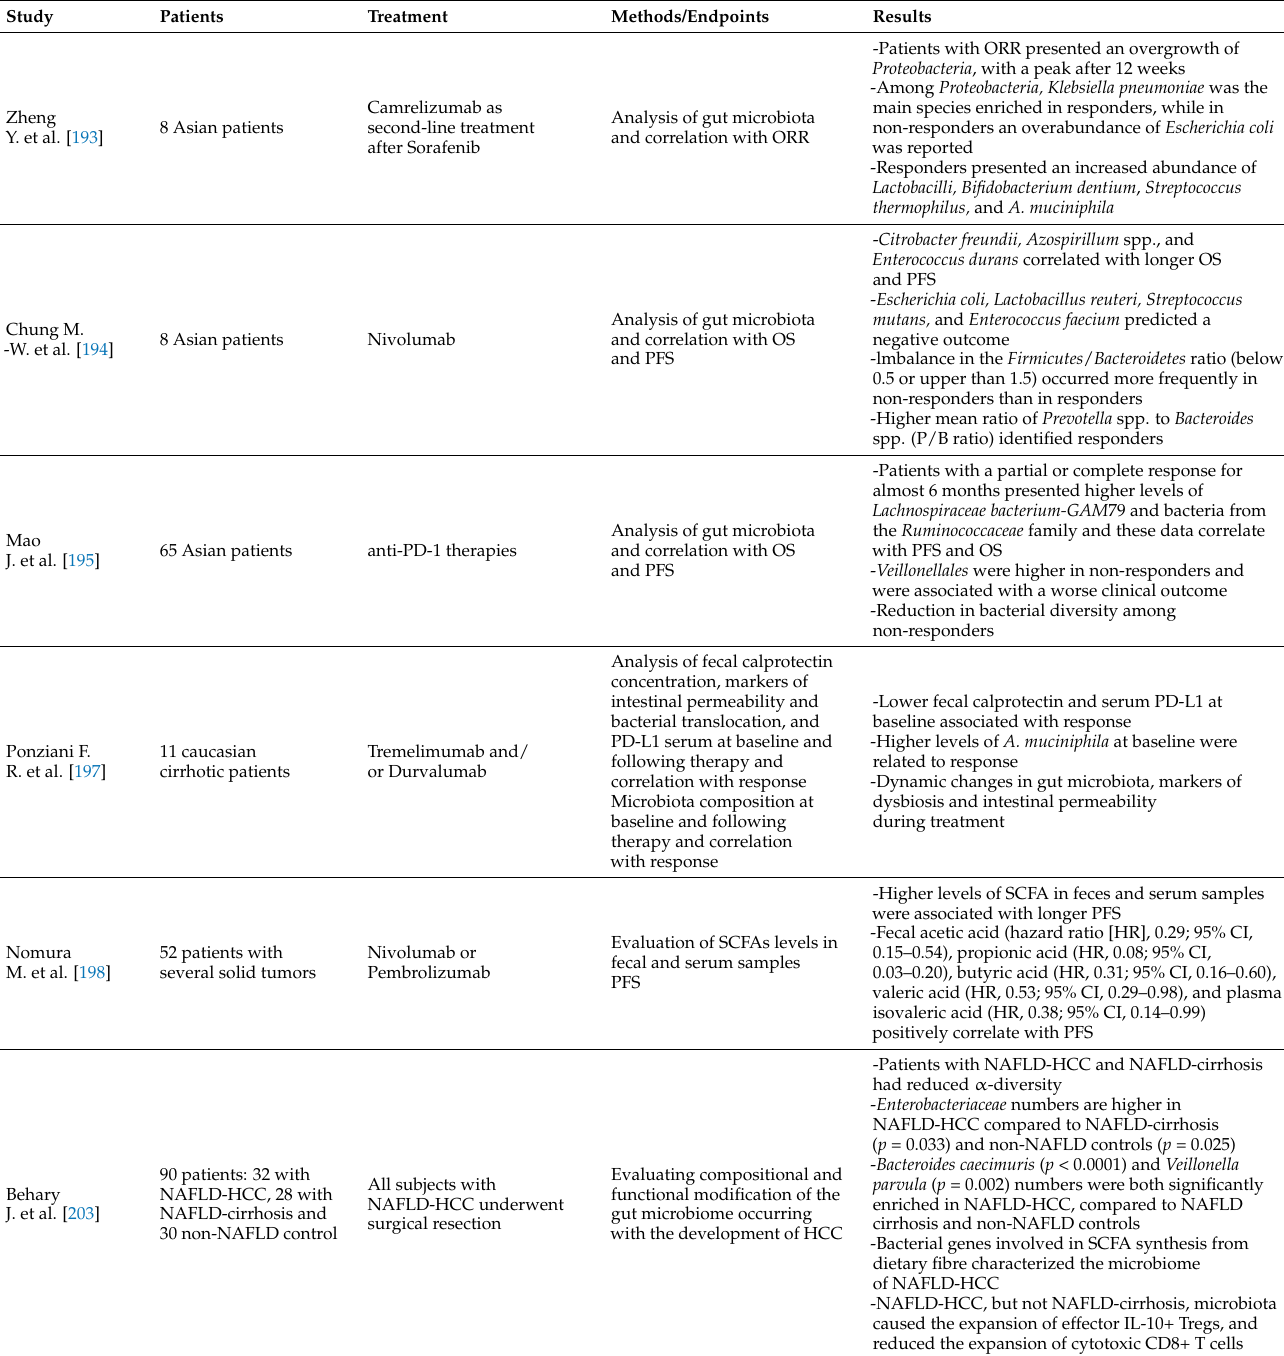
Table 3. Studies evaluating the gut microbiota as biomarkers in patients treated with immune checkpoints inhibitors